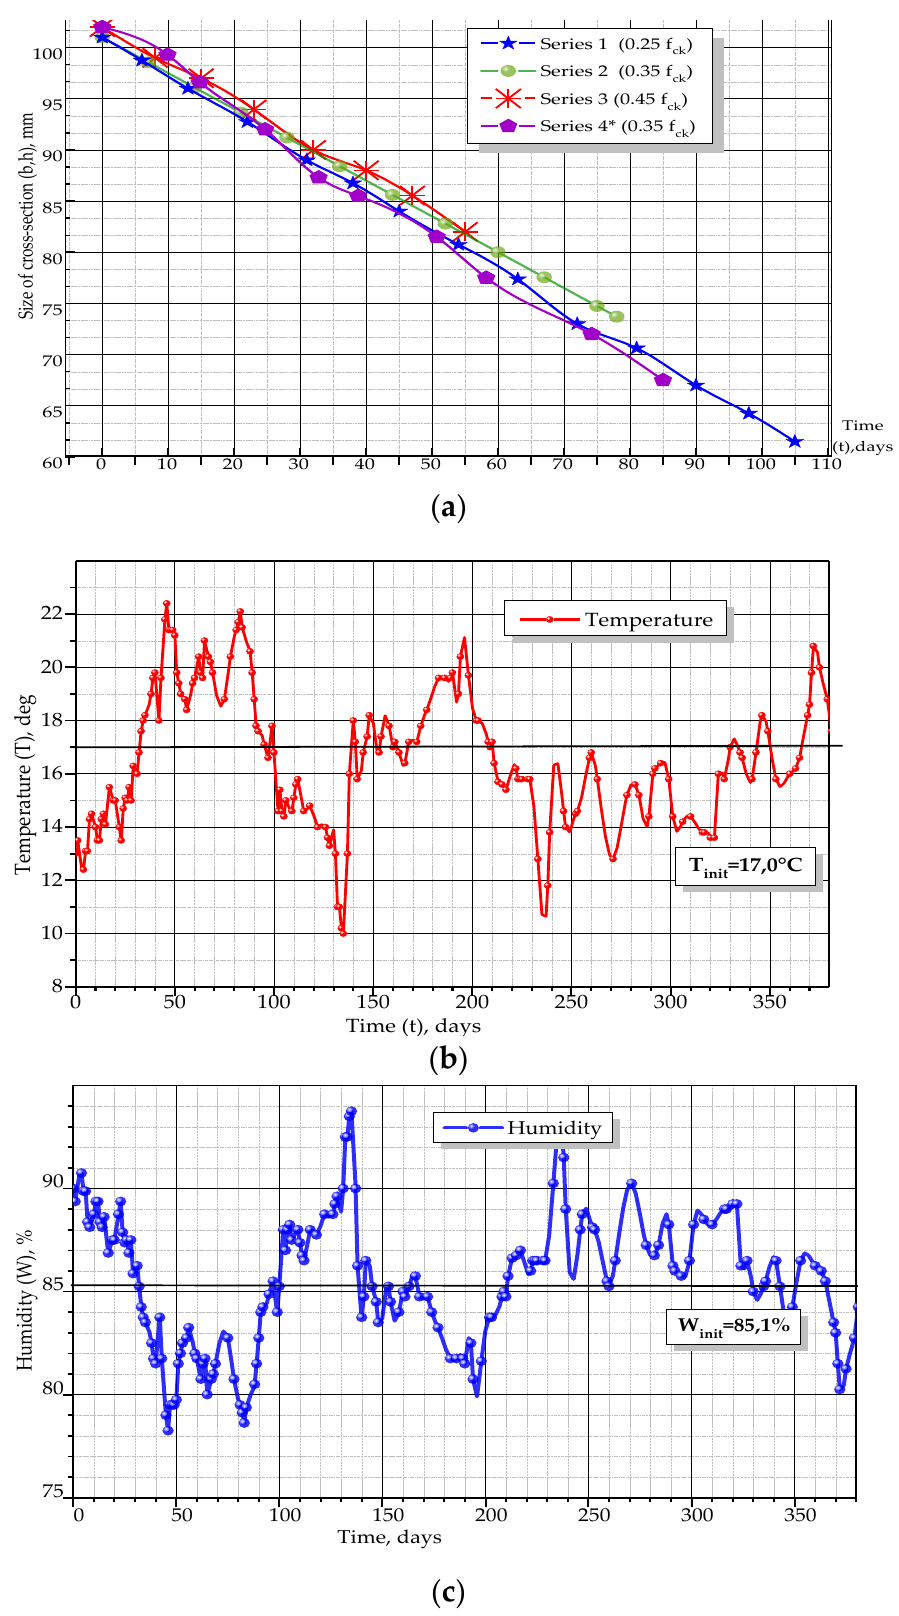
Figure 8. Recordings made during the experiment: ( a ) changes in cross-section sizes for prisms, ( b ) changes of temperature and ( c ) changes of humidity.